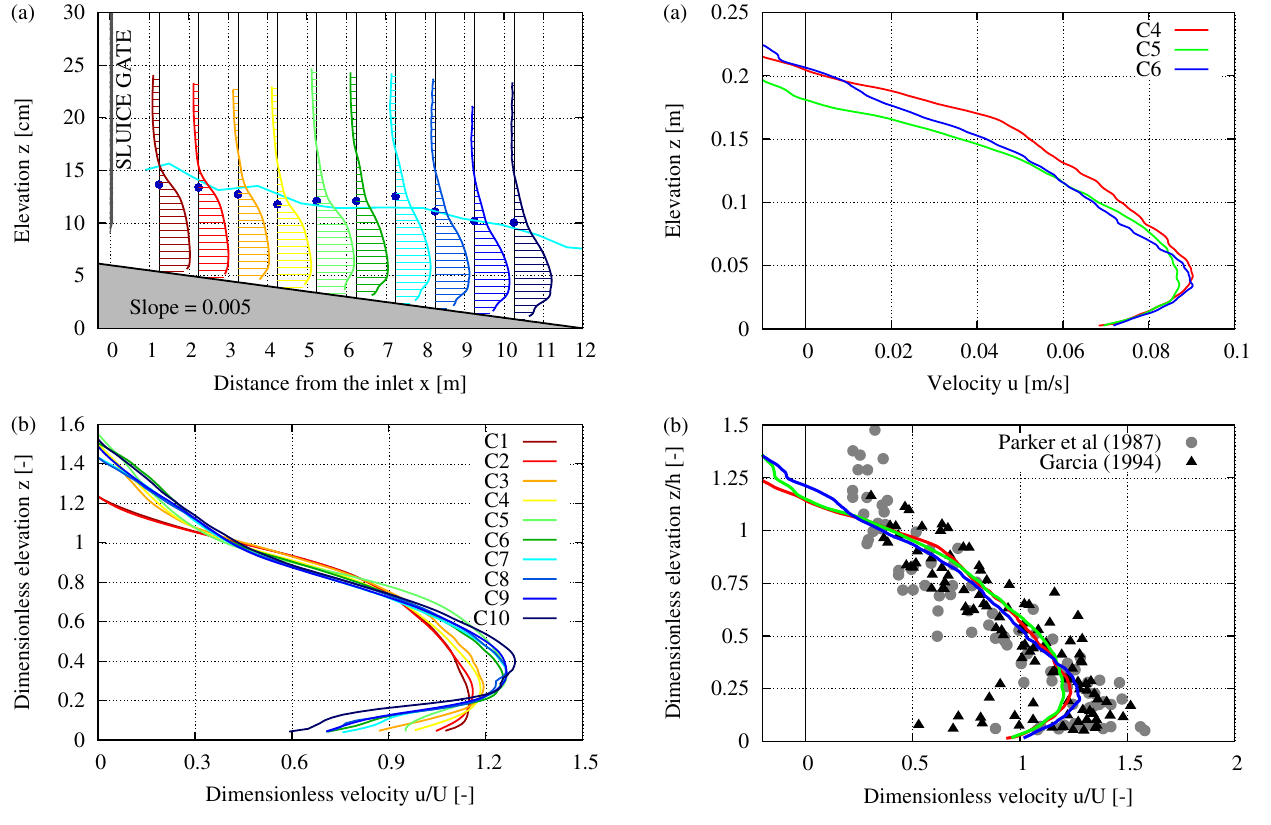
Figure 6. Example of velocity profiles: (a) dimensional velocity profiles and (b) dimensionless velocity profiles in di ff erent cross sections from experiment S25 ( q 0 = 0 . 0069m 2 s − 1 ; ∆ ρ/ρ = 0 . 6%). The points corresponding to the experimental observations of su- percritical currents of Parker et al. (1987) and both supercritical and subcritical currents of Garcia (1994) are also reported.